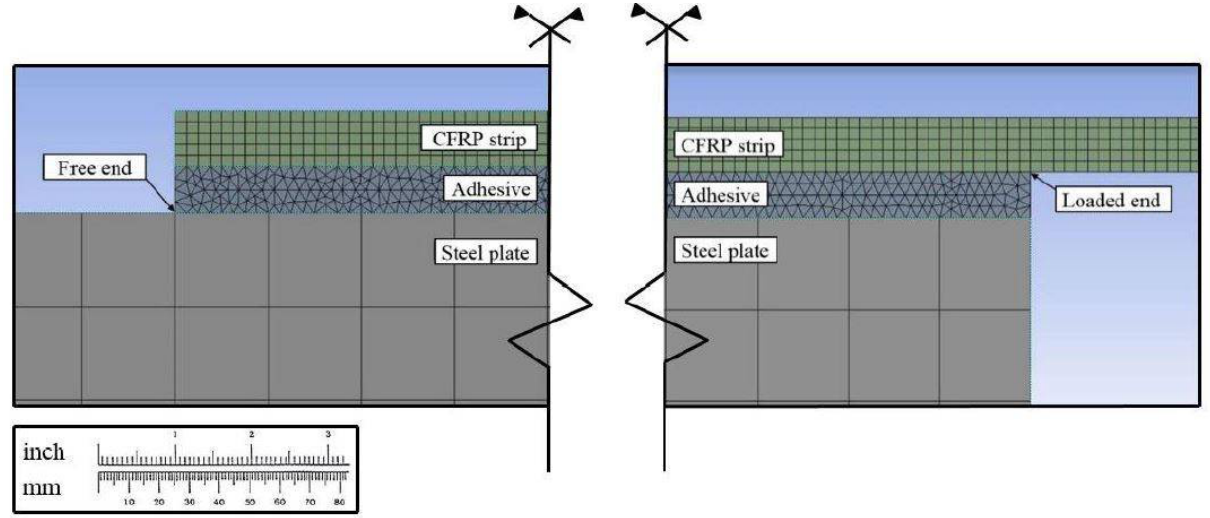
Figure 18. FE discretization at the extremities of the bond length.